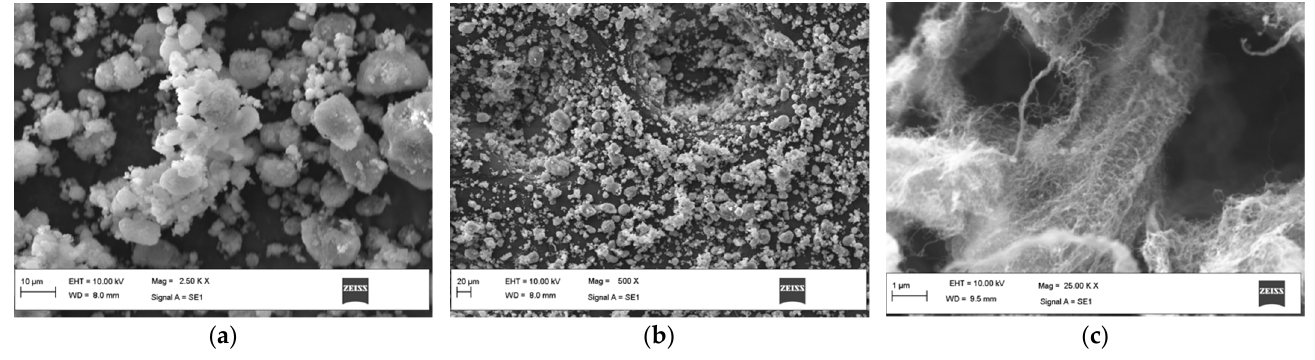
Figure 2. SEM images of ( a ) Nano-iron oxide, ( b ), Nano-silica, and ( c ) MWCNTs. Table 3. Properties of